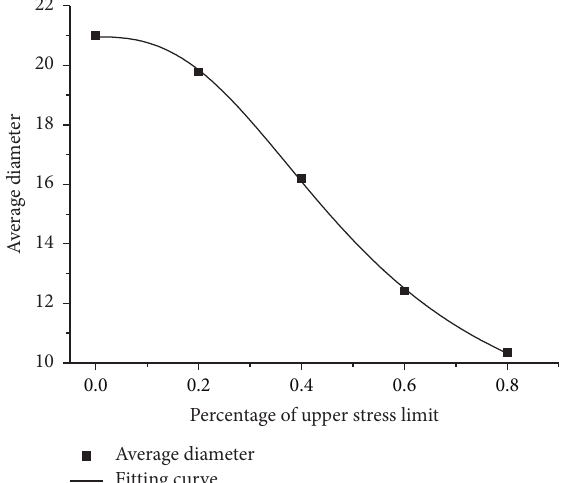
Figure 7: Fitting curve of fracture characteristics of damaged sandstone under impact